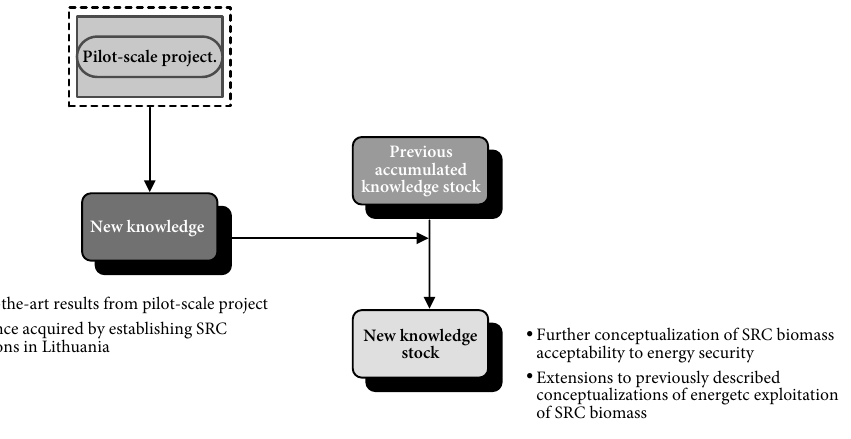
Fig. 5. The key research achievements of the pilot-scale project